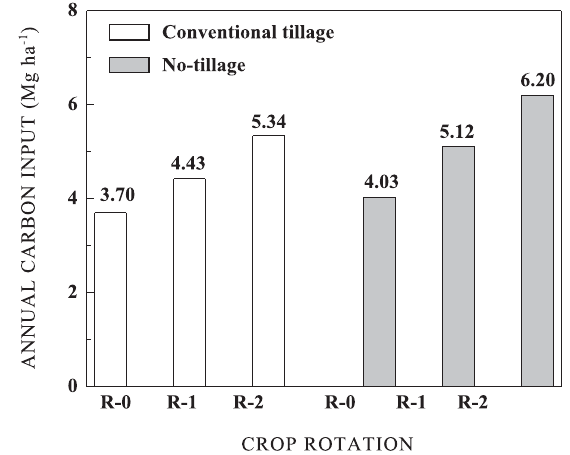
Figure 1. Average annual carbon input by crop rotations in a subtropical Oxisol under conventional and no-tillage systems during the period of 1985/86 to 2003/04. (R0=wheat/soybean; R1=wheat/soybean/black oat/soybean; R2=black oat/soybean/black oat+common vetch/maize/ oilseed radish/wheat/soybean). Vertical bars represent the LSD (0.79) by the t test at